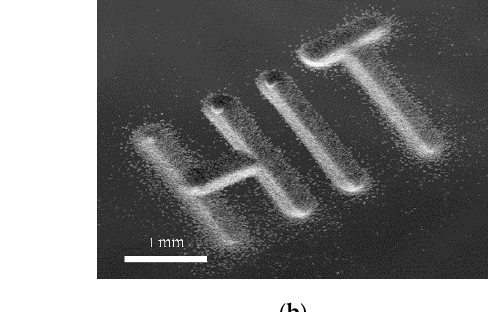
Figure 11. Linear groove pattern. ( a ) Sample of the microgroove and ( b ) profile of the microgroove.